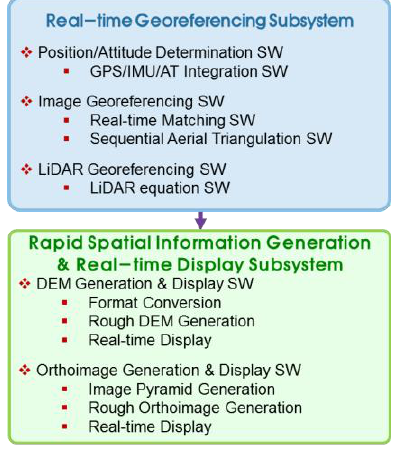
Figure 7. Outline of the processing system